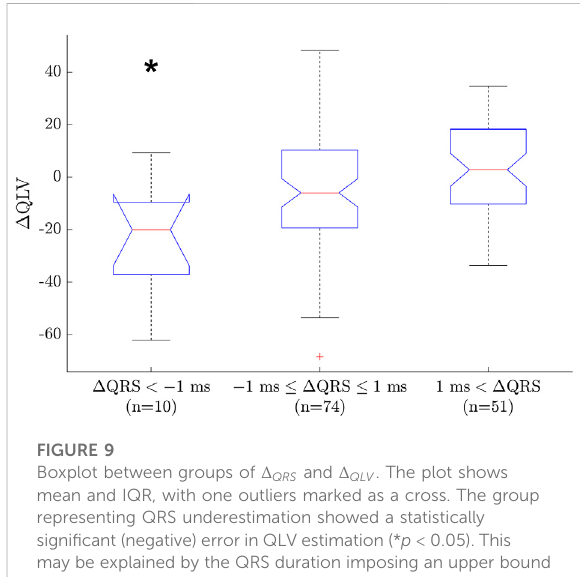
FIGURE 9 Boxplot between groups of Δ QRS and Δ QLV . The plot shows mean and IQR, with one outliers marked as a cross. The group representing QRS underestimation showed a statistically signi fi cant (negative) error in QLV estimation (* p < 0.05). This may be explained by the QRS duration imposing an upper bound on the QLV